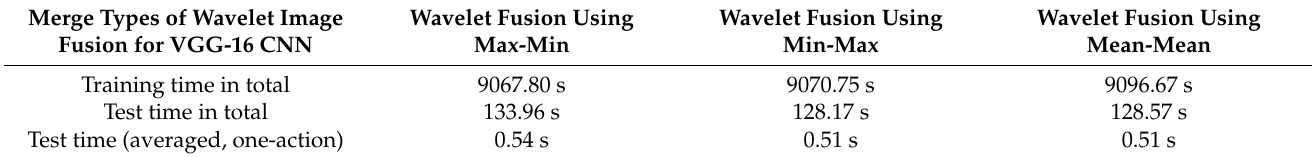
Figure 21. Recognition rate (a) and loss value (b) curves of the VGG-16 CNN model training using mean-mean wavelet fused images. Table 8. Training and test time of the hand gesture intention recognition of the proposed VGG-16 CNN deep learning with wavelet image fusion of CCD RGB-IR and depth-grayscale using “max-min”, “min-max” or “mean-mean” merge types on the hand gesture database (10 classes of gesture intention actions with 25 actions collected in each class contained in each of the training and test databases).